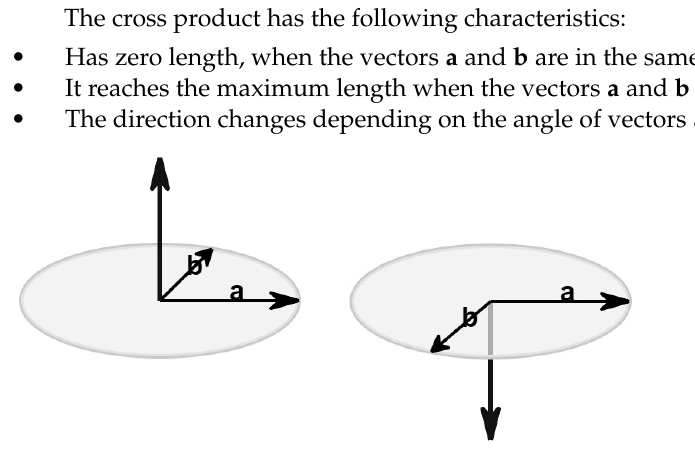
Figure 31. The cross product equals the area of a parallelogram with vectors a and b used as sides of the parallelogram.